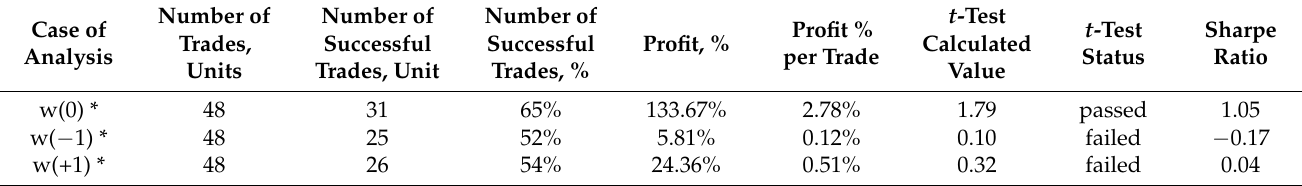
Table 4. Trading simulation results for expiration price effects: weekly